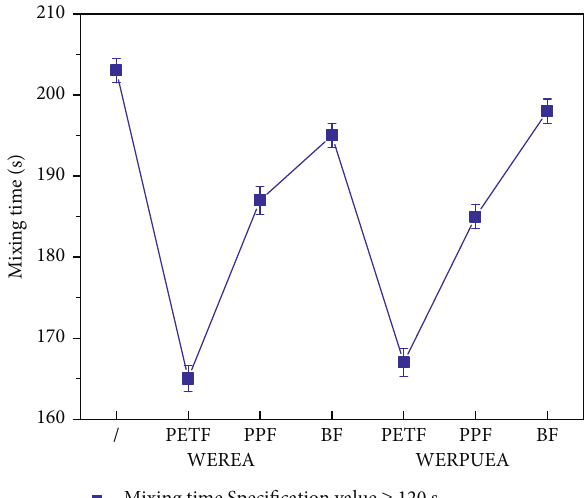
Figure 5: Mixing time of different types of microsurfacing. 0.51.01.52.02.53.0